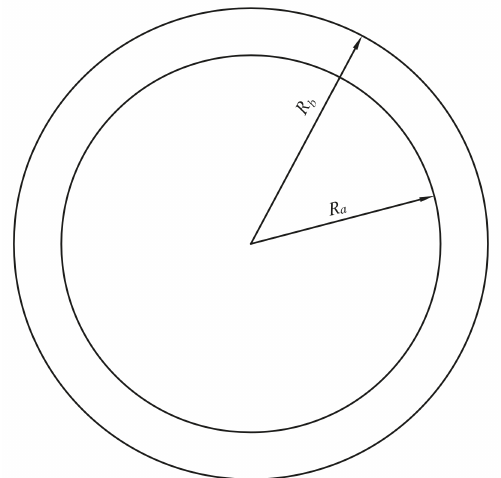
Figure 9. Free vibration analysis of an annulus.